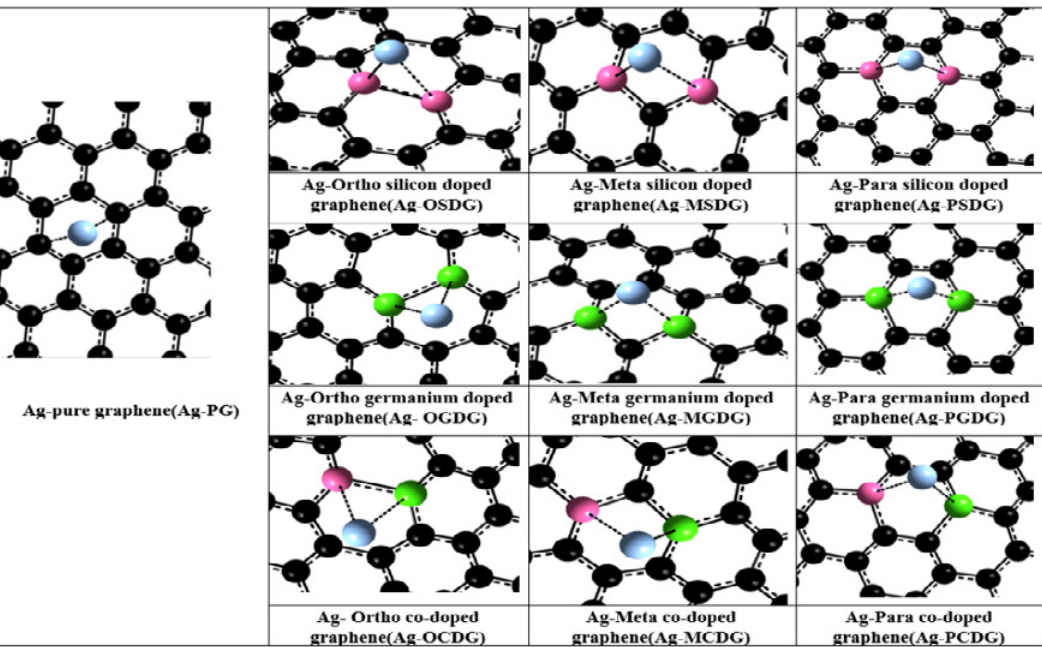
Fig. 3. The optimized structures of the derived complexes of silver with various nano adsorbents and their abbreviated names Atom colors: black—carbon, green—germanium, pink—silicon, and blue—silver